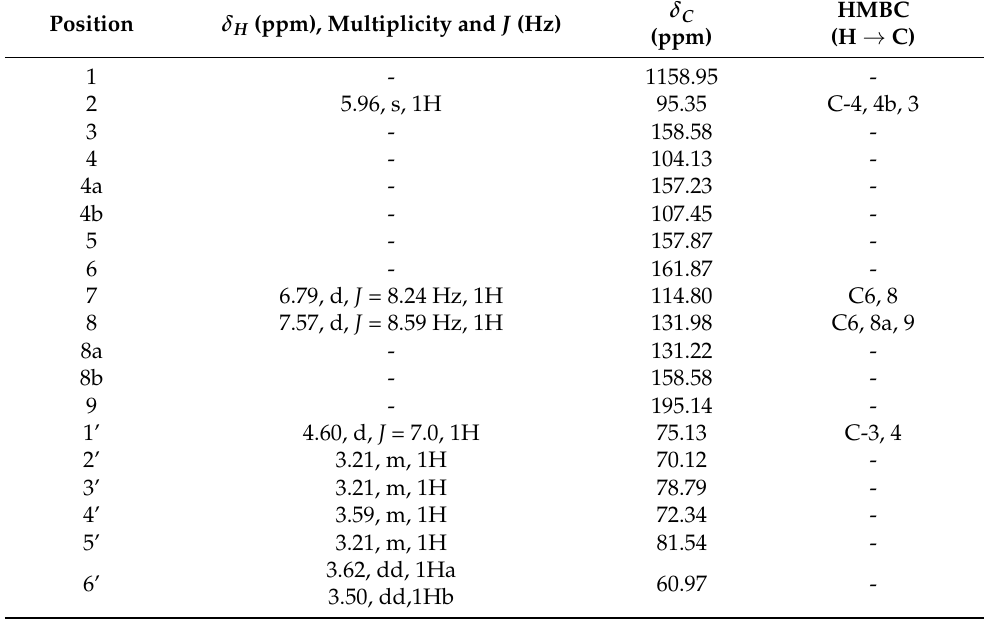
Table 1. 1 H- NMR, APT, and HMBC spectral data of isolated compound (recorded at 400/100 MHz in DMSO- d 6 ; δ in ppm, J in